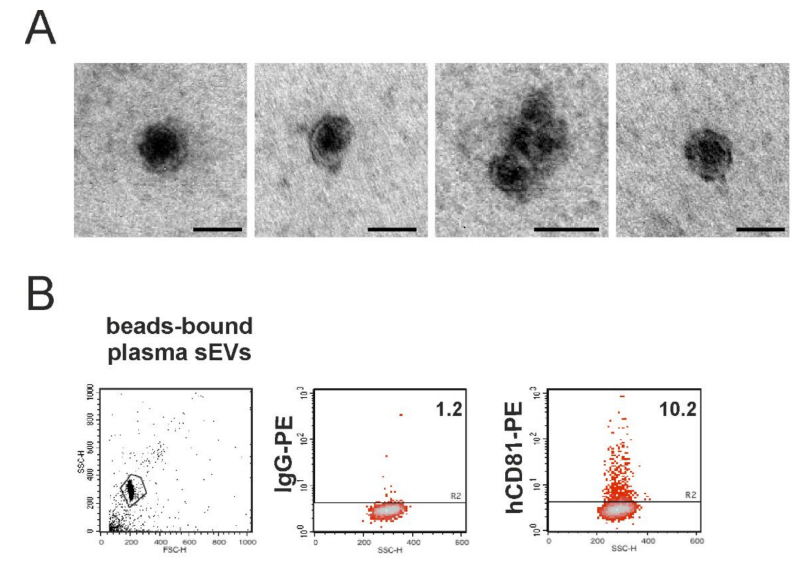
Figure 3. Detection of human sEVs in the mouse plasma. ( A ) TEM analysis of the sEVs purified from the mouse plasma. Bars, 100 nm when not indicated. ( B ) sEVs purified from the mouse plasma were immunocaptured by the magnetic beads conjugated to human CD63 tetraspanin and then processed for immunofluorescence of the human CD81-PE. Aggregates and debris were excluded (gating) from the fluorescence analysis, as shown in the cytogram relative to the light scatter parameters (left panel). The number reported in each cytogram represents the percentage of